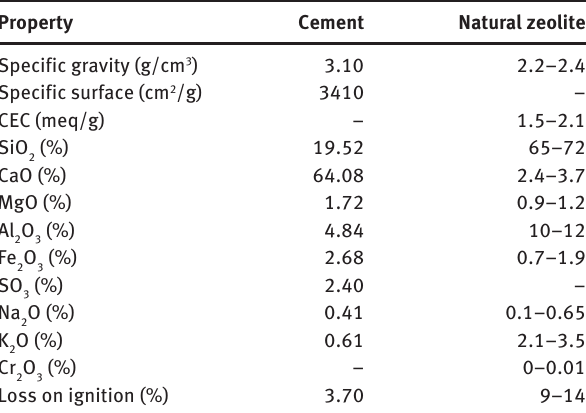
Table 3 Physical and chemical composition of the additives. Property